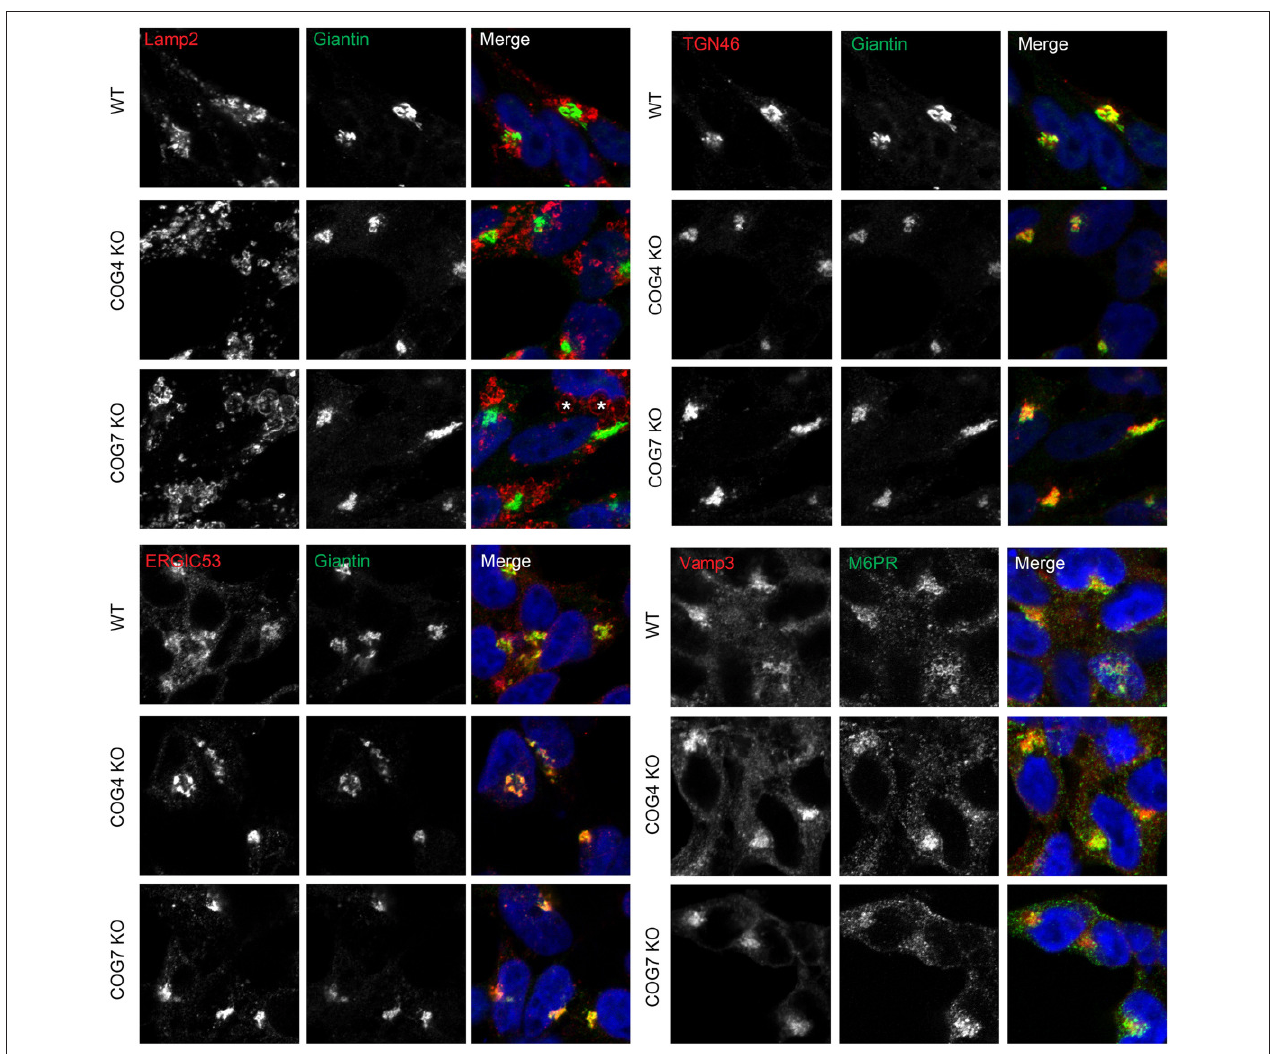
FIGURE 5 | Golgi and other secretory markers are largely undisturbed in Cog KO cells. Immunofluorescence of Lamp2, Giantin, ERGIC53, TGN46, Vamp3, and M6PR. Asterisks in Cog7 KO indicate Lamp2-positive, large, endocytic-like structures, Cog4 structures not pictured.